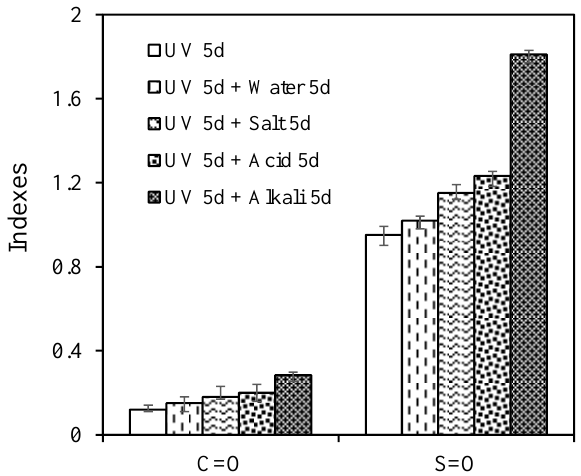
Figure 10. I C=O and I S=O of asphalt after the multiple aging of UV and aqueous solution.